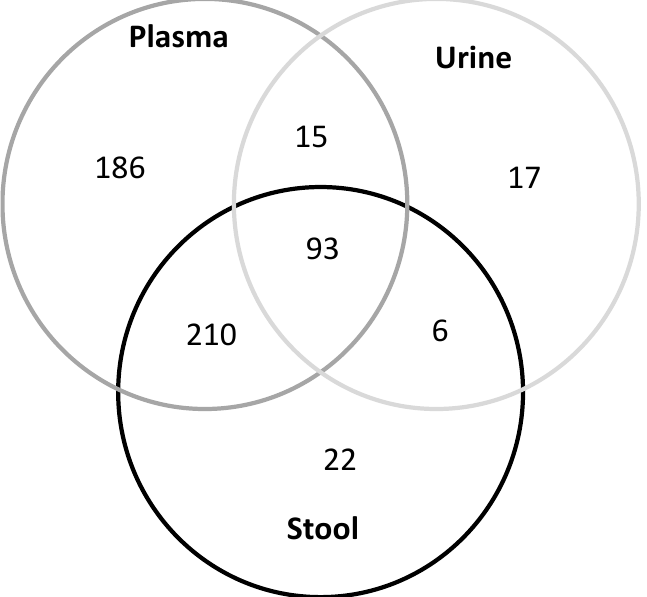
Figure 2. Venn diagram of metabolites measurable in plasma, feces, and urine.